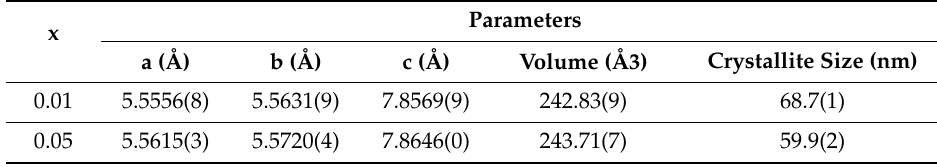
Table 1. Crystallographic parameters of the LaFe 1 − x Zr x O 3 annealed at 800 ◦ C for 6 h, obtained by the FullProf 2k